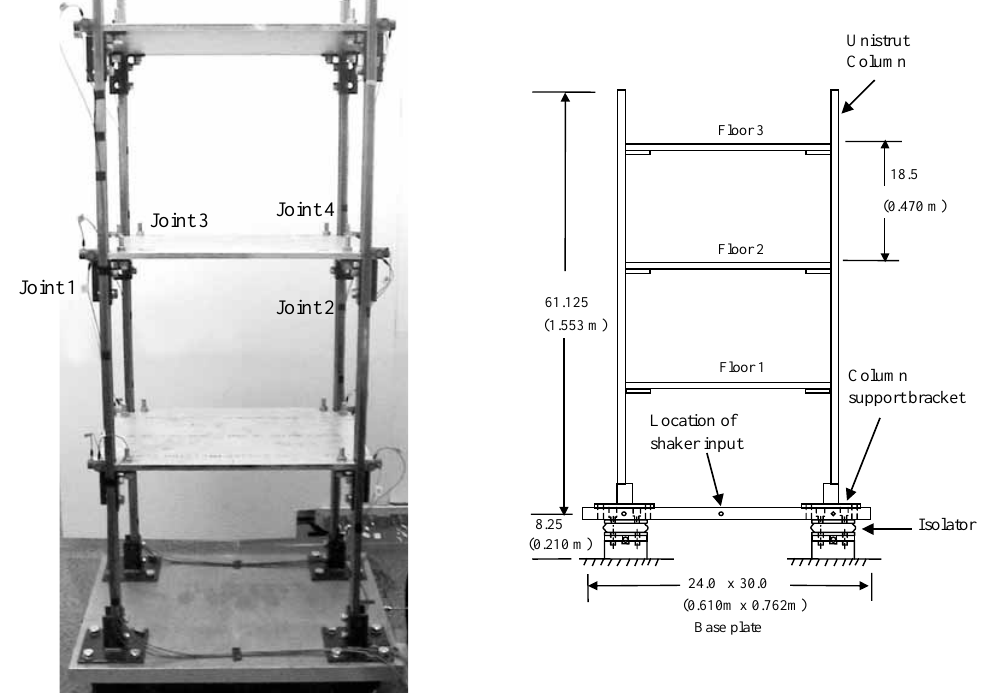
Fig. 1. Scaled Model of a 3-Story Building Structure.